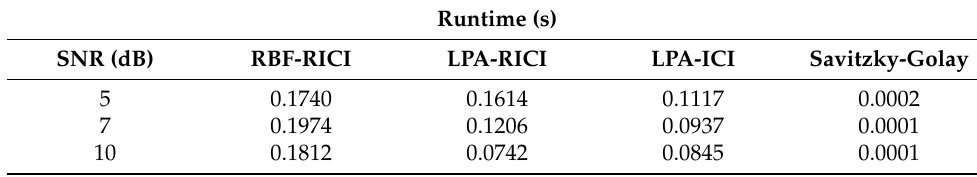
Table 14. Bumps signal—Filtering algorithms’ runtimes.